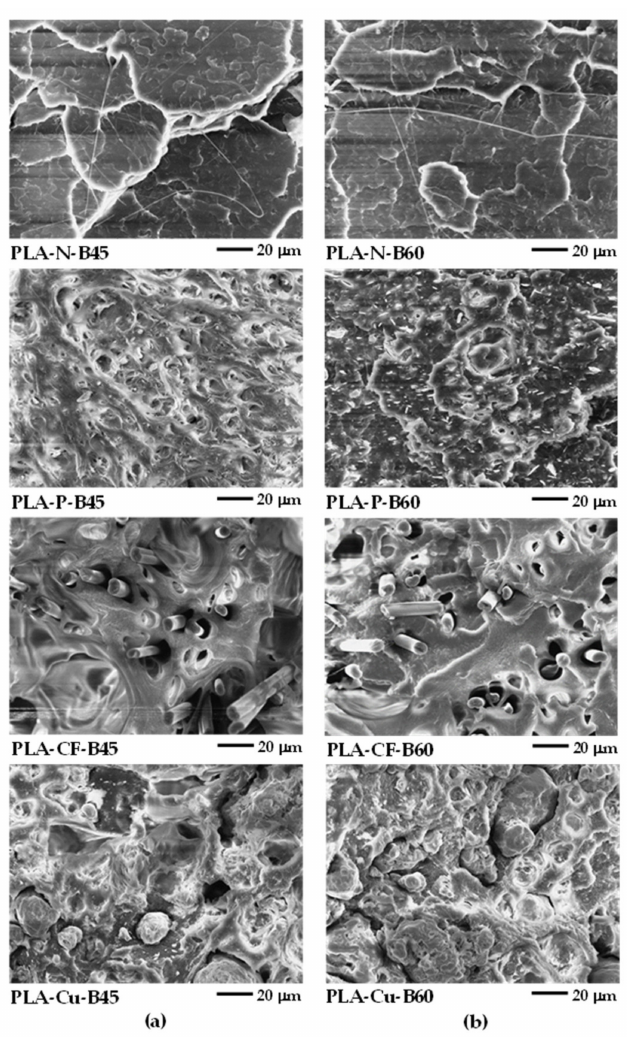
Figure 15. SEM images of tensile fractured surfaces of 3D printed samples at high magnification ( × 1000): ( a ) at bed 45 ◦ C and ( b ) at bed 60 ◦